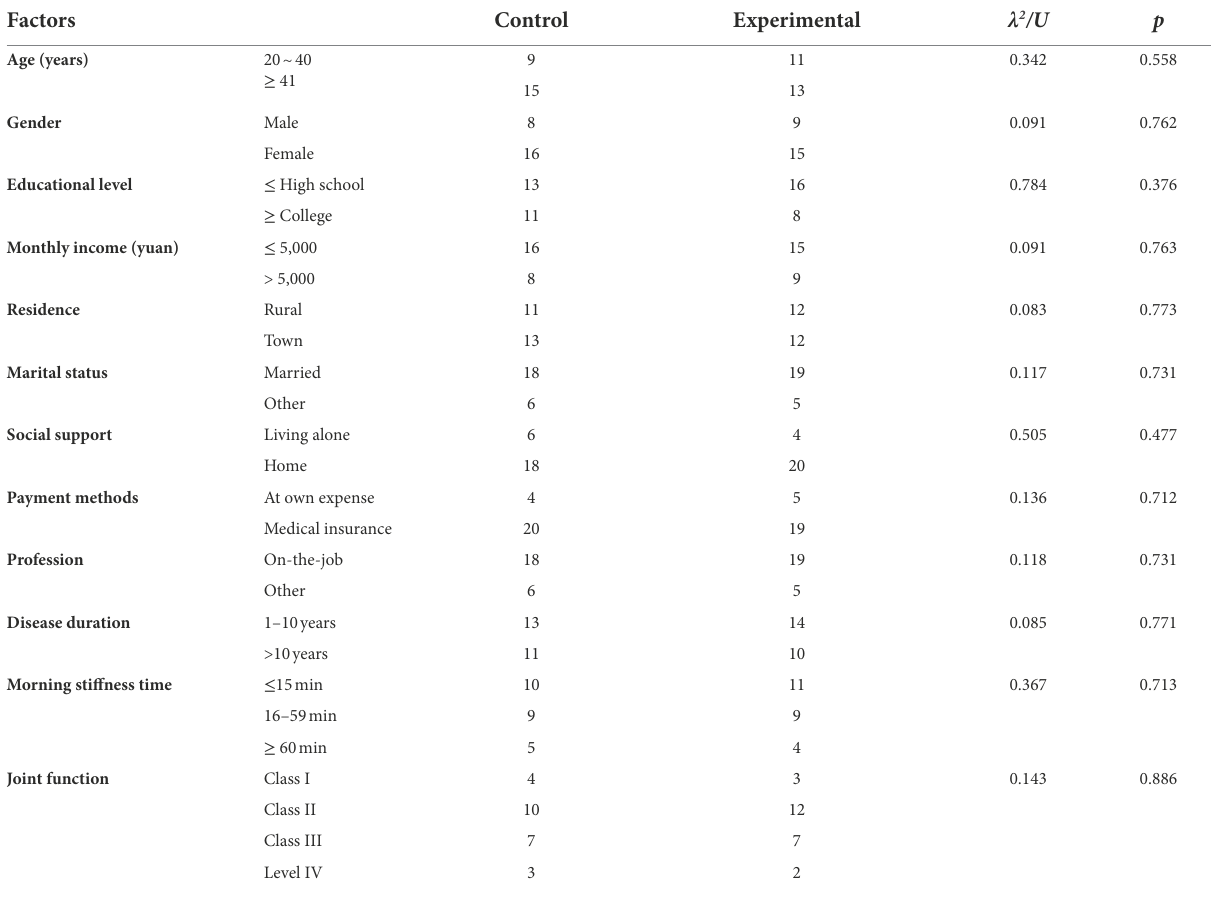
TABLE 1 Between-group comparison of patient characteristics.